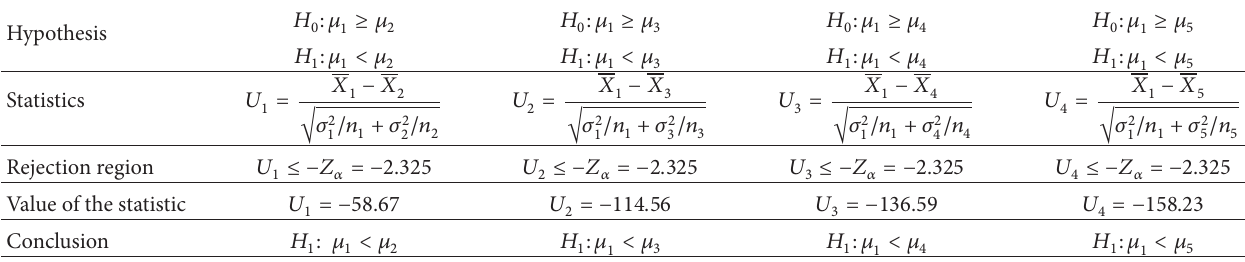
Table 1: Hypothesis testing for experimental results.